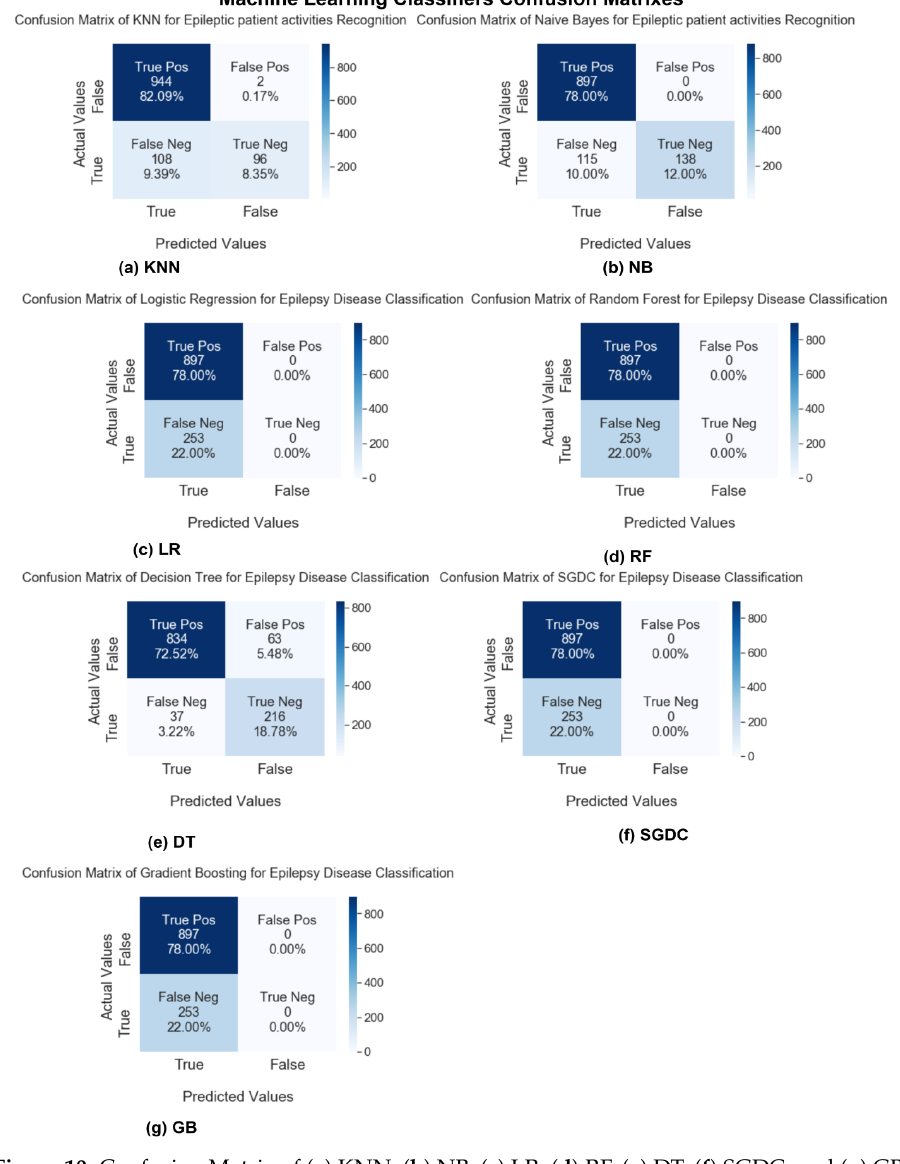
Figure 10. Confusion Matrix of ( a ) KNN, ( b ) NB, ( c ) LR, ( d ) RF, ( e ) DT, ( f ) SGDC, and ( g ) GB.